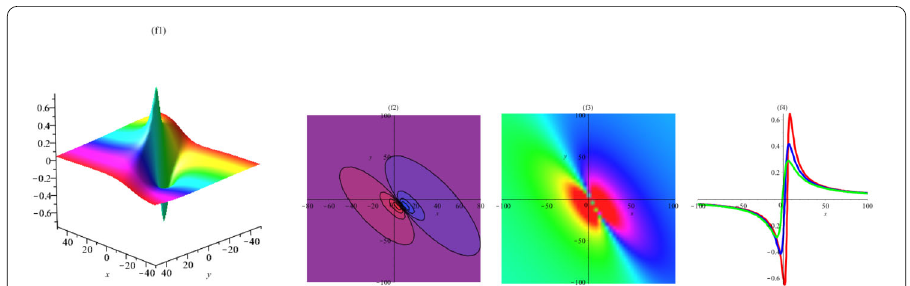
Figure 1 The plot of rogue wave (3.5) with fractional order α = 0.5